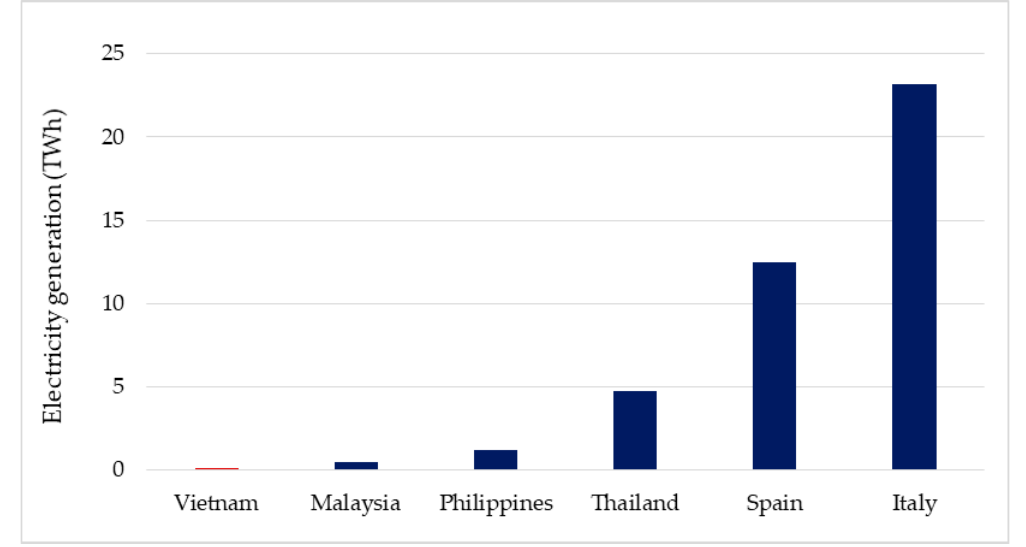
Figure 3. Electricity generation by solar power in selected countries as of 2018.